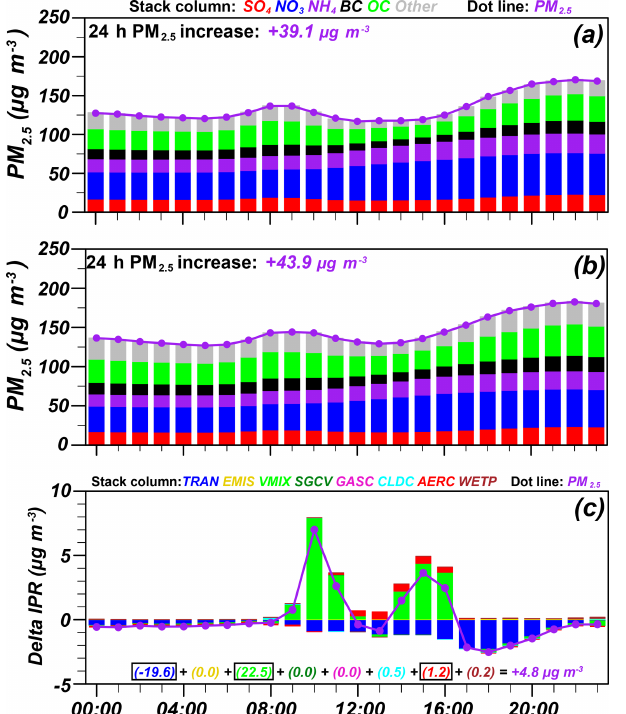
Figure 11. Diurnal variations of the near-surface PM 2 . 5 concentra- tions in the (a) NoARE and (b) CTL simulations averaged over the Beijing–Tianjin–Hebei region during Stage 1 (purple dotted lines). The colored bars represent different components. The 24h increase in PM 2 . 5 concentration (23:00 minus 00:00LST) is also shown in the top-left corner of each panel. (c) Differences in hourly IPRs caused by aerosol radiative forcing (CTL minus NoARE). The num- bers listed in panel (c) represent the contributions of each process to the change in the 24h PM 2 . 5 increase caused by aerosol radiative forcing.